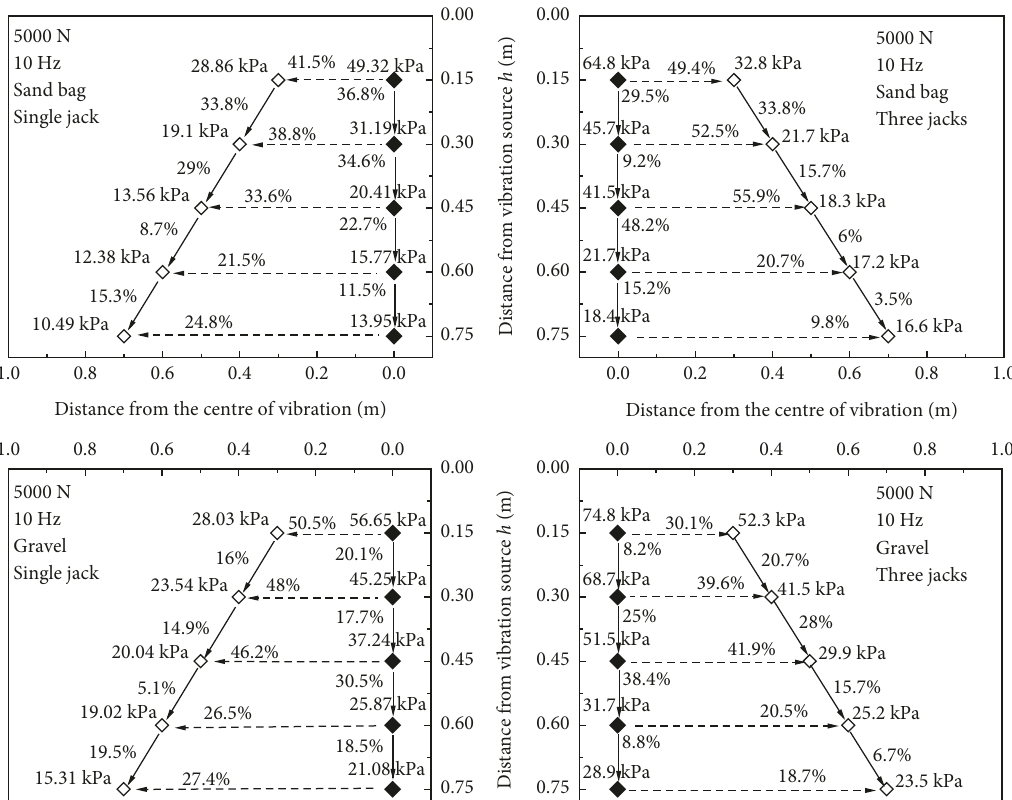
Figure 19: Effective soil pressure of the central and slope areas under different